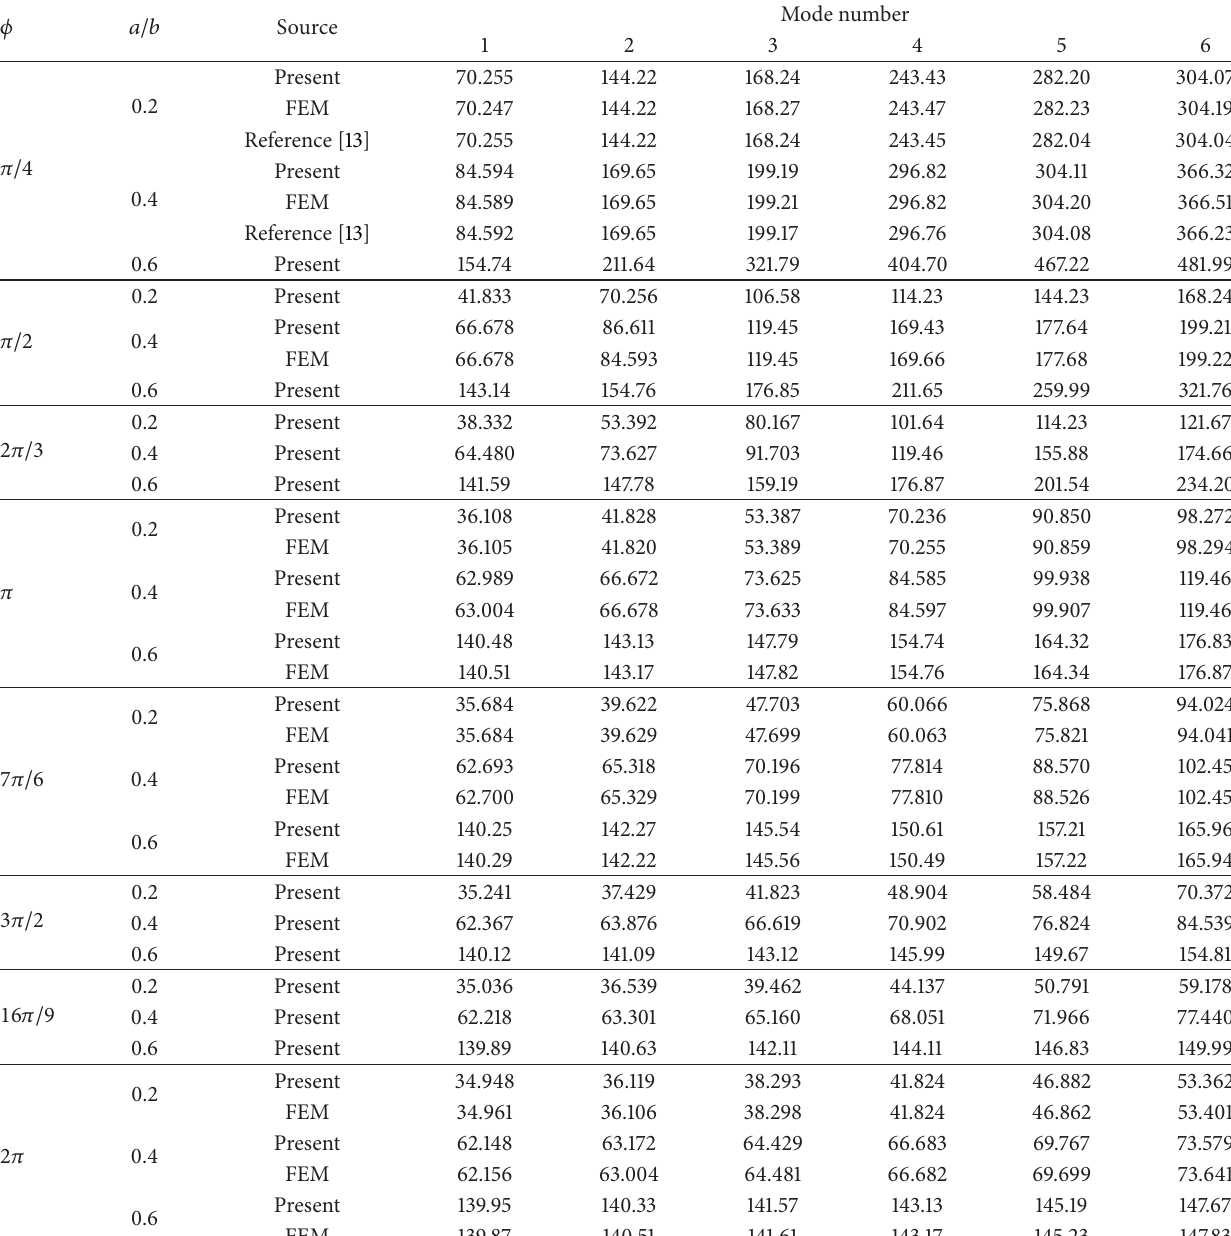
Table 5: Frequency parameters, Ω = 𝜔𝑏 2 (𝜌ℎ/𝐷) 1/2 , for CSCS annular sector plates ( 𝜇 = 0.3